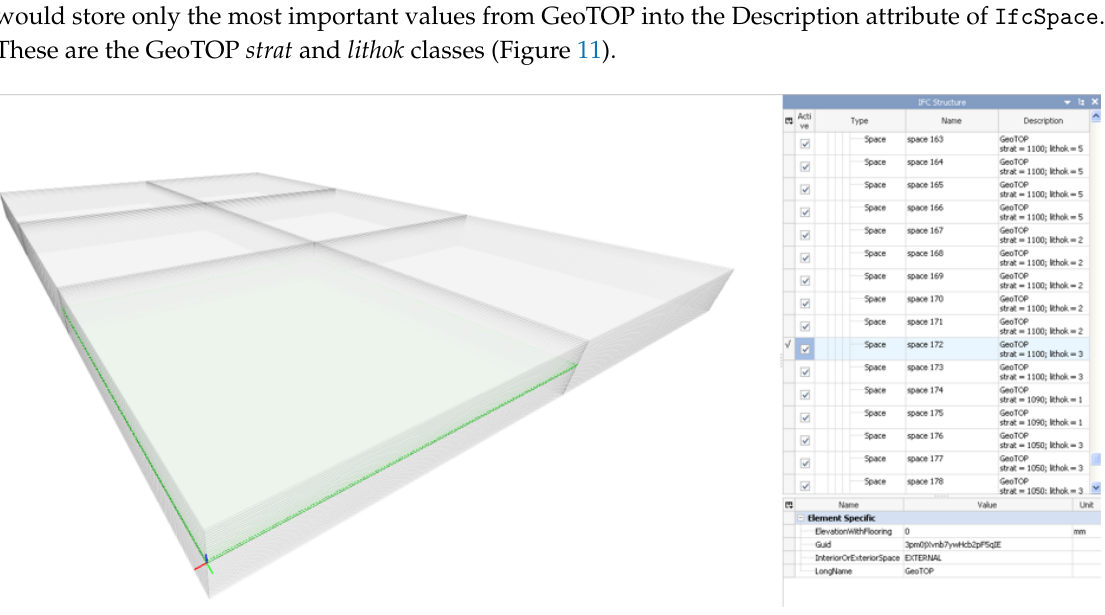
Figure 11. Produced voxels from the GeoTOP underneath the Faculty of Architecture of the TU Delft (visualised on BIM Vision